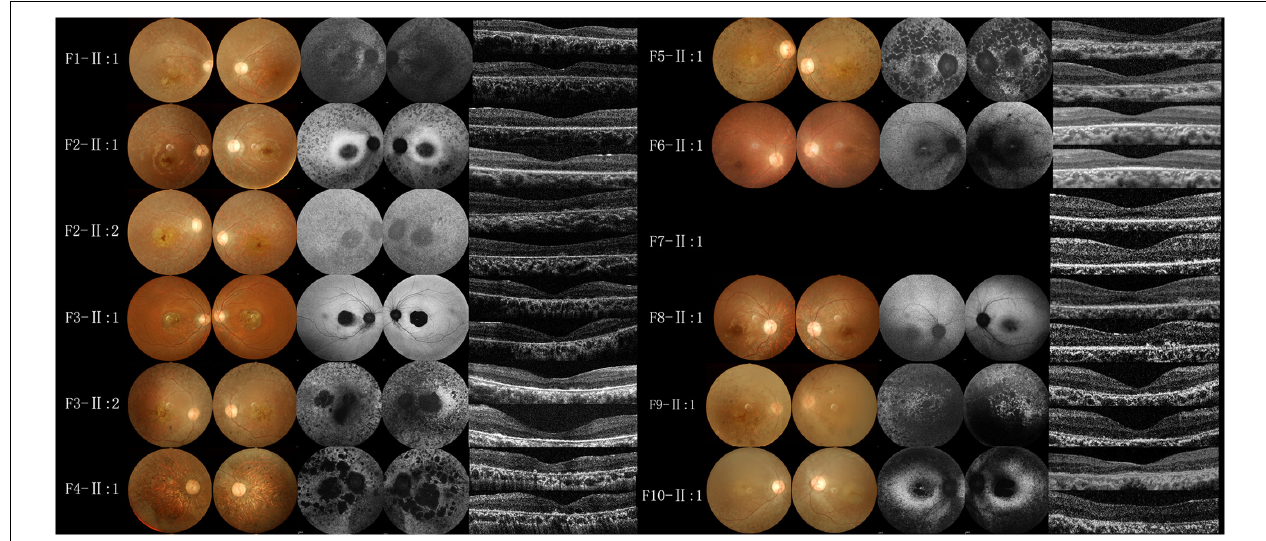
FIGURE 2 | Fundus photography, fundus autofluorescence imaging, and foveal optical coherence tomography scans of probands from the BBS families. All patients had macular lesions, with pigmentary changes in the peripheral and midperipheral retina, attenuated arteriolar vessels, and pallor of the optic disk (Fundus). Plaque hypoautofluorescence in the macular area was enlarged in F1-II:1, F2-II:1, F2-II:2, F3-II:2, F4-II:1, F5-II:1, F9-II:1 (FAF). OCT (OD and OS in the vertical order) showed the outer structure of the subfovea was completely absent in F1-II:1, most of the outer structure remained in F6-II:1, and different degrees of deletion of the outer structure of the subfovea were observed in the rest of the patients